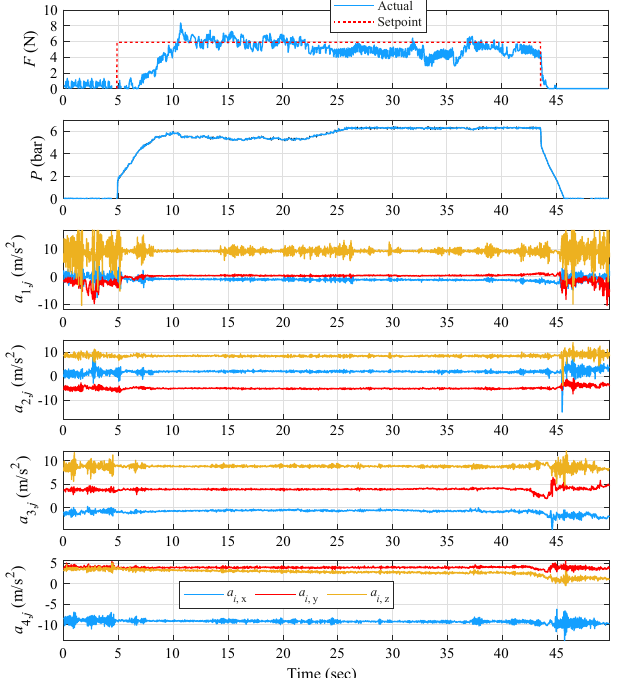
Figure 16. Experimental evaluation of iteration (B) and the effect of applying resisting force on the ET-diagnosed volunteer’s metacarpal under closed-loop reference in applied pressure and while the hand is in a straight position; Exp. 1.